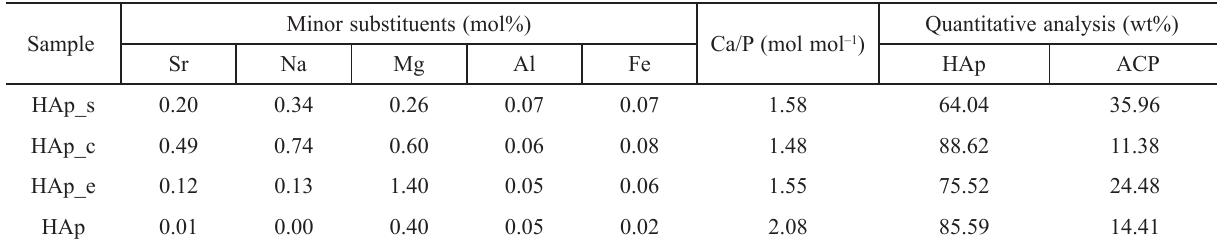
Table 1 – Results of ICP-MS analysis and quantitative analysis of as-prepared CaP phases performed by Rietveld refinement of the XRD data